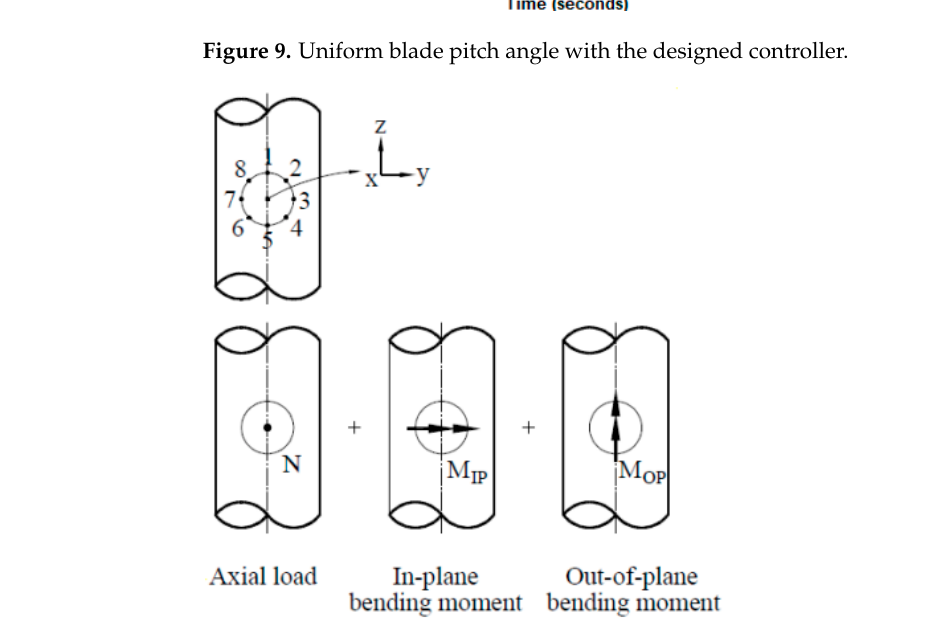
Figure 11. Flowchart of software modules. 5. Results and Discussion The modelling parameters significantly affect the dynamic behaviour of the jacket, which also affects the fatigue life. Optimising the stiffness-to-mass ratio by varying design parameters to reach the perfect design is a typical feature of effective structural design. It